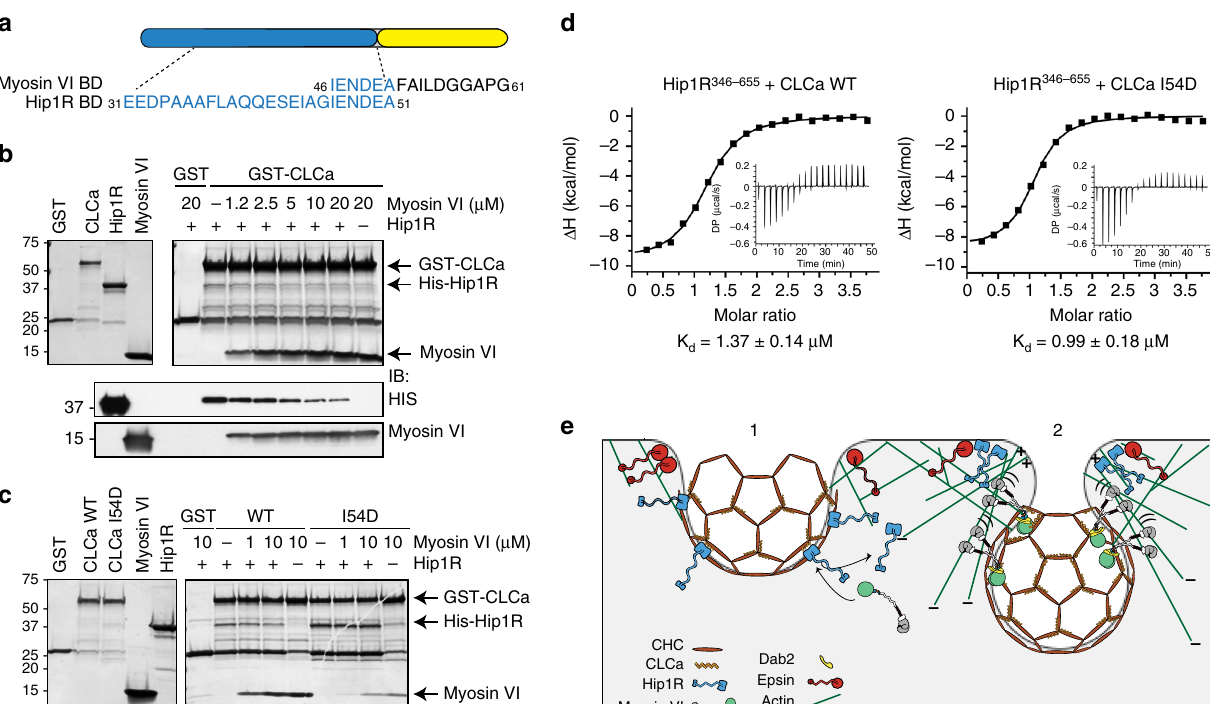
Fig. 6 Myosin VI and Hip1R are mutually exclusive binders of CLCa. a Binding regions of myosin VI and Hip1R on CLCa. b Competitive binding assay. Bacterially puri fi ed His-Hip1R coiled-coil region spanning residues 346 – 655 (2.5 µ M) pre-incubated with GST-CLCa full-length protein (1 µ M) for 1 h at 4 °C was mixed with increasing amounts of myosin VI 1050 – 1131 as indicated. Bottom panel, Coomassie staining. Lower panels, 1/10 of the elutant was loaded for immunoblotting with the indicated antibodies. c As in b but using GST-CLCa I54D mutant. d ITC experiments with the indicated proteins. The integrated heat and raw plots are reported. Equilibrium dissociation constants ( K d ) obtained by the fi tting are indicated below. Relevant ITC measurements are reported in Table 2. e A putative model of clathrin-coated pit fi ssion in polarized tissue. Once CCP passes the endocytic checkpoint, it undergoes a maturation process mediated by PIP2 turnover and the activity of several endocytic accessory factors (e.g., Hip1R). (1) As the bud expands, myosin VI is recruited to CCPs by CLCa and disengages Hip1R, which preferentially associates with epsin at the CCP edge. Actin anchoring and polymerization is thereby restricted to the neck of the invaginating pit where Hip1R along with epsin provide a link between actin nucleation and the CCP. Alternatively, formation of a complex between epsins and Hip1R at the neck would recruit Hip1R from the coat, exposing the myosin VI-binding site on CLCa and causing recruitment of myosin VI to the CCP. (2) Myosin monomer bound to CLCa anchors the CCP to the actin meshwork engaged in retrograde fl ow and facilitates movement of the vesicle into the cytoplasm. After dimerization induced by Dab2 or oligomerization, myosin VI becomes a processive motor that walk toward the minus end of actin fi laments providing mechanical force to oppose membrane tension in polarized tissues and promoting the fi nal dynamin-mediated fi ssion step (not depicted). Future experiments are needed to test this model. In the myosin VI representation, the boxing glove and white cuff indicate the motor domain and single IQ motif, respectively, while the cargo-binding tail, which includes the clathrin-binding domain, is depicted as a green sphere; the black squiggly connecting region includes the 3HB and SAH